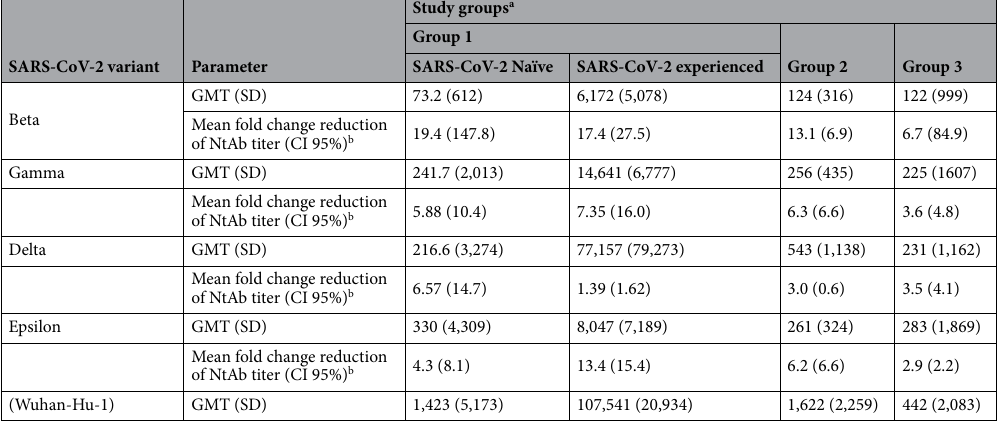
Table 2. Serum neutralizing antibody titers against SARS-CoV-2 variants across study groups. CI confidence interval, GMT geometric mean titer, NtAb neutralizing antibodies, SD standard deviation. a Group 1, nursing home residents fully vaccinated with the Comirnaty vaccine; Group 2, healthy individuals fully vaccinated with the Comirnaty vaccine; Group 3, unvaccinated, COVID-19 recovered individuals that required hospitalization in internal medicine or intensive care units. b Relative to the NtAb titer against WA1/2020.